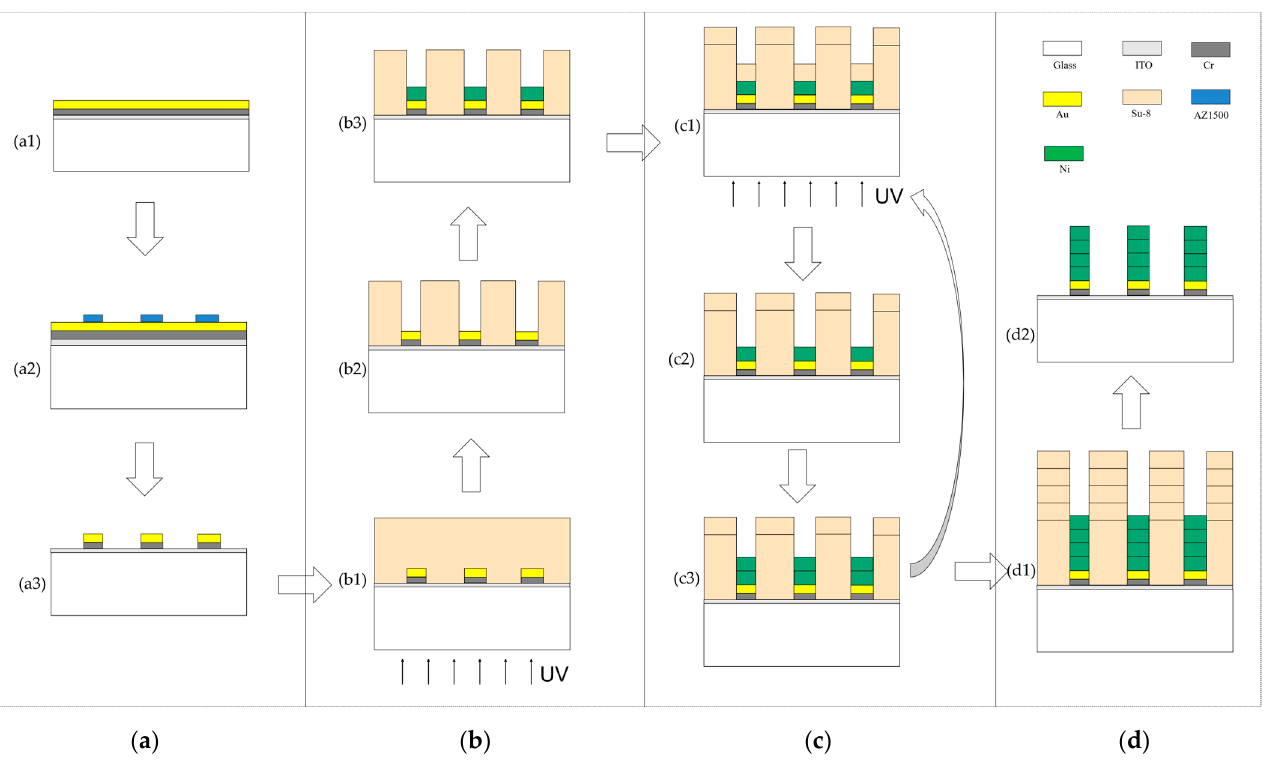
Figure 2. Fabrication processes of microstructure in the proposed fabrication method. ( a ) Prepare the patterned seed layer: ( a1 ) Cr/Au seed layer, ( a2 ) front lithography and development of AZ1500 photoresist, ( a3 ) removal of AZ1500 photoresist; ( b ) first back-alignment lithography and electro- forming: ( b1 ) spin SU-8 and back-alignment lithography, ( b2 ) development, ( b3 ) electroforming; ( c ) repeated back-alignment lithography and electroforming to achieve the required thickness of the electroforming layer: ( c1 ), ( c2 ) and ( c3 ), respectively, are repetitions of ( b1 ), ( b2 ) and ( b3 ); ( d ) removal of photoresist: ( d1 ) the result of multi-step back-alignment lithography and electroforming, ( d2 ) removal of the SU-8 photoresist.